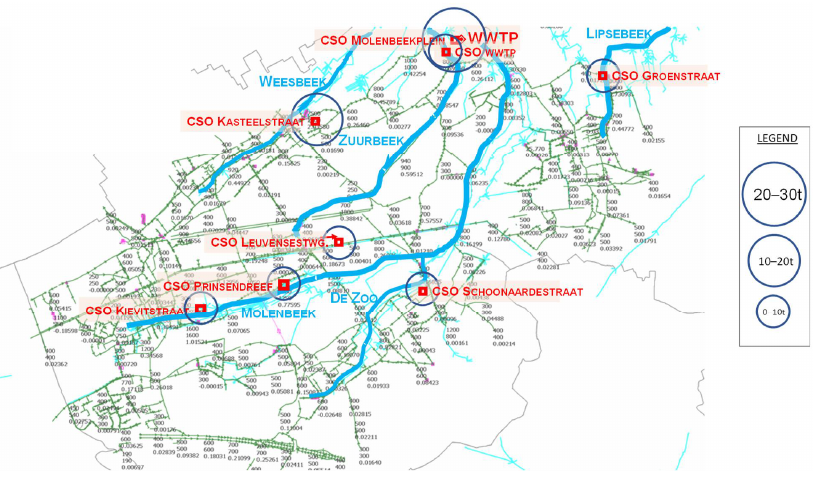
Figure 10. Example of GIS-based reporting: map of Kortenberg catchment including sewer system (green), receiving watercourses (blue), and locations of major emission points from urban wastewater system (red: WWTP and main CSOs). Circles indicate the magnitude of emitted annual loads (in